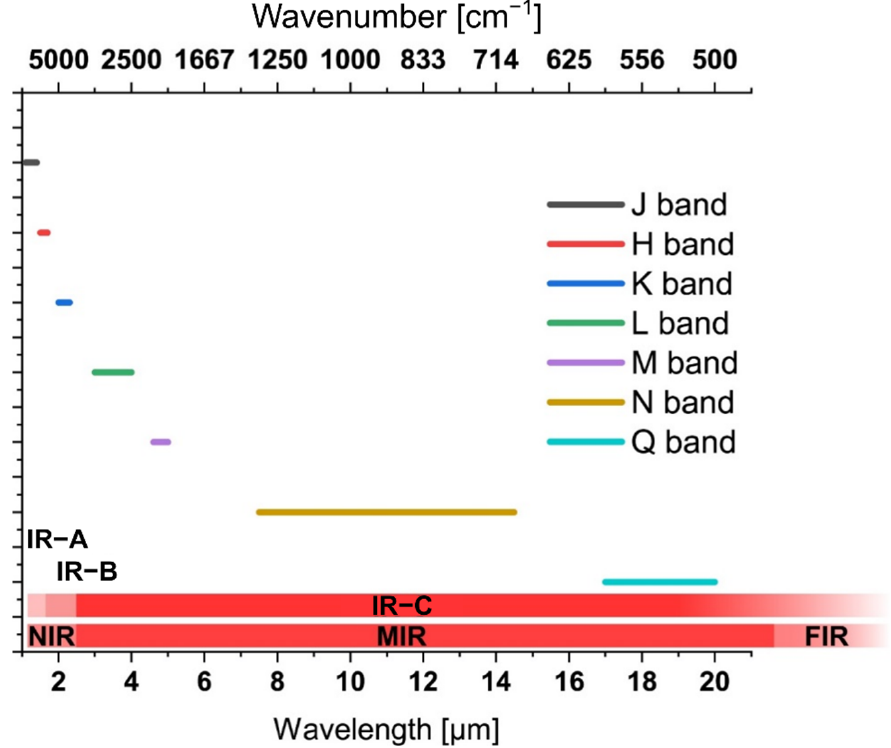
Figure 1. Electromagnetic wavelength regime defined as ‘infrared’ with associated classification of transitions.